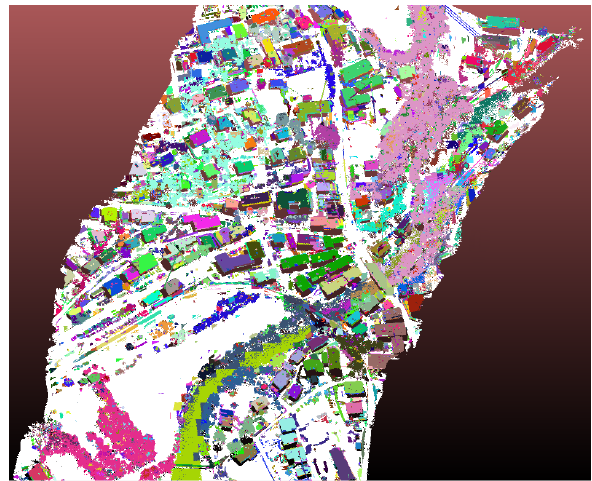
Figure 10. Result of the segmentation of the non-ground segment. The maximum Voxel dimension is x,y < 20m, z < 2m. The segments in the point clouds are colour coded: white: ground, others: randomly different